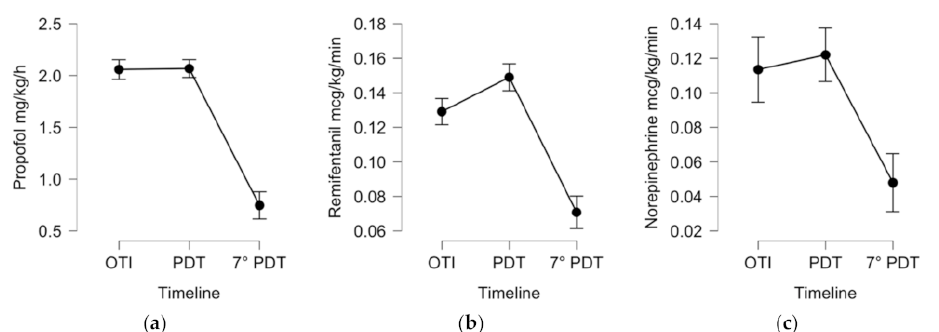
Figure 3. Descriptive plots, means, and 95% confidence intervals of 110 ICU COVID-19 patients who underwent PDT using repeated measures ANOVA for the following variables: Propofol ( a ), Remifentanil ( b ), and Norepinephrine ( c ) administered by intravenous continuous infusion during the ICU stay. Legend: OTI, day of orotracheal intubation; PDT, day of percutaneous tracheostomy; 7 ◦ PDT, day 7 after tracheostomy.